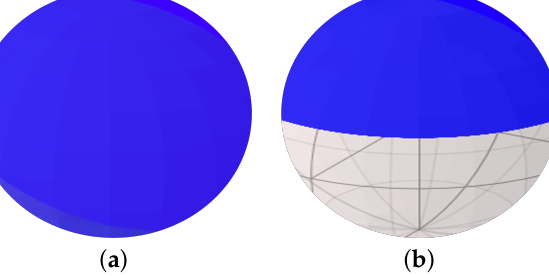
Figure 2. Mapping (cid:126) n of the ( k x , k y ) plane represented by − 10 < k x < 10 and − 10 < k y < 10 region (with wavectors in nm − 1 ) onto a Bloch sphere for the ( a ) topological, inverted band regime where M < 0 and B > 0, and ( b ) topologically trivial regime with normally ordered bands for M > 0 and B > 0. The topology of the two Bloch spheres is different, ( b ) contains a hole and ( a ) does not. The parameters of the topological regime are M = − 150 meV, B = 107 meVnm 2 , and v f = 600 meVnm, while in the topologically trivial regime the parameters are M = + 150 meV, B = 107 meVnm 2 , and v f = 600 meVnm [36].